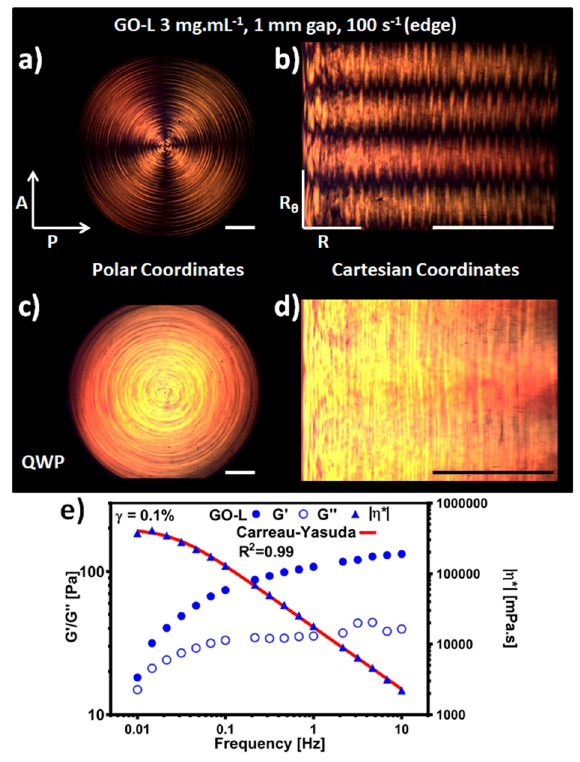
Fig. 2 PLIs and oscillatory rheology of 3 mg mL − 1 GO-L. PLIs of 3 mg mL − 1 GO-L obtained during a shear pulse using angular speed ω = 8 rad s − 1 (sample edge shear rate is 100 s − 1 ). a Using linearly polarized light and represented in polar coordinates as recorded, arrows labeled by P and A de fi ne polarization plane orientations of polarizer and analyzer, respectively, and b a corresponding transformed image represented in Cartesian coordinates. The two- line plots R θ — tangential and R — radial show directions at which two different features can be observed: Maltese cross in the R θ direction and apparent vorticity shear bands in the R direction. c Using circularly polarized light produced by quarter wave plates (QWP) and represented in polar coordinates, and d a corresponding transformed image represented in Cartesian coordinates. Diameter of the PLI is 25 mm (corresponding to the diameter of the top plate). e Frequency sweep of GO-L performed using parallel-plate geometry in oscillatory mode (disc diameter 60 mm and a gap d = 0.5 mm). Red line represents the Carreau-Yasuda-model fi tting using Eq. (2). Scale bar on SIPLIs depicts 5.86 isogyres) and isolate the SB, Rheo-SIPLI was repeated on GO-L using a circularly polarized light produced by quarter wave plates (QWPs) incorporated in the optical path (Fig. 2c). In this setup, only circles of apparent vorticity shear bands corresponding to lines of constant birefringence (usually called isochromatic or isostress lines) 48 are observed. The circularly PLIs (Fig. 2d), reveal the fact that the bands are continuous and virtually concentric around the axis of rotation. This observation, combined with a closer inspection of the polar and Cartesian representations of the linearly polarized PLI (Fig. 2a, b) reveals that in fact, the pattern consists of concentric bands, each containing a frustum of the MC alternately offset in opposite tangential directions.